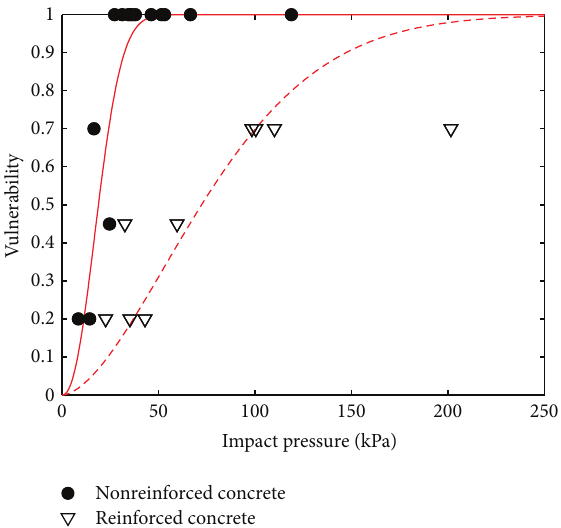
Figure 4: Vulnerability curves depending on impact pressure [6].